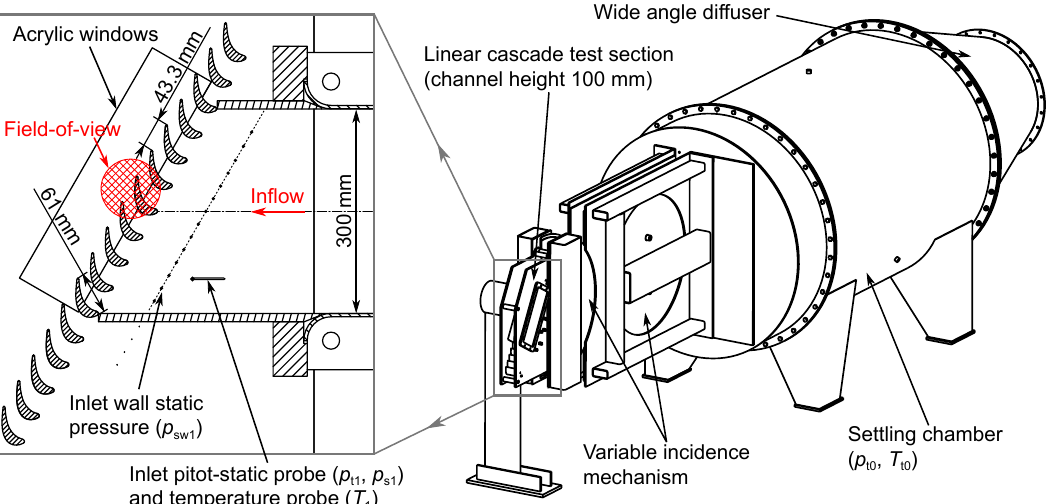
Figure 10. Sketch of the transonic cascade wind tunnel with details of the linear cascade test